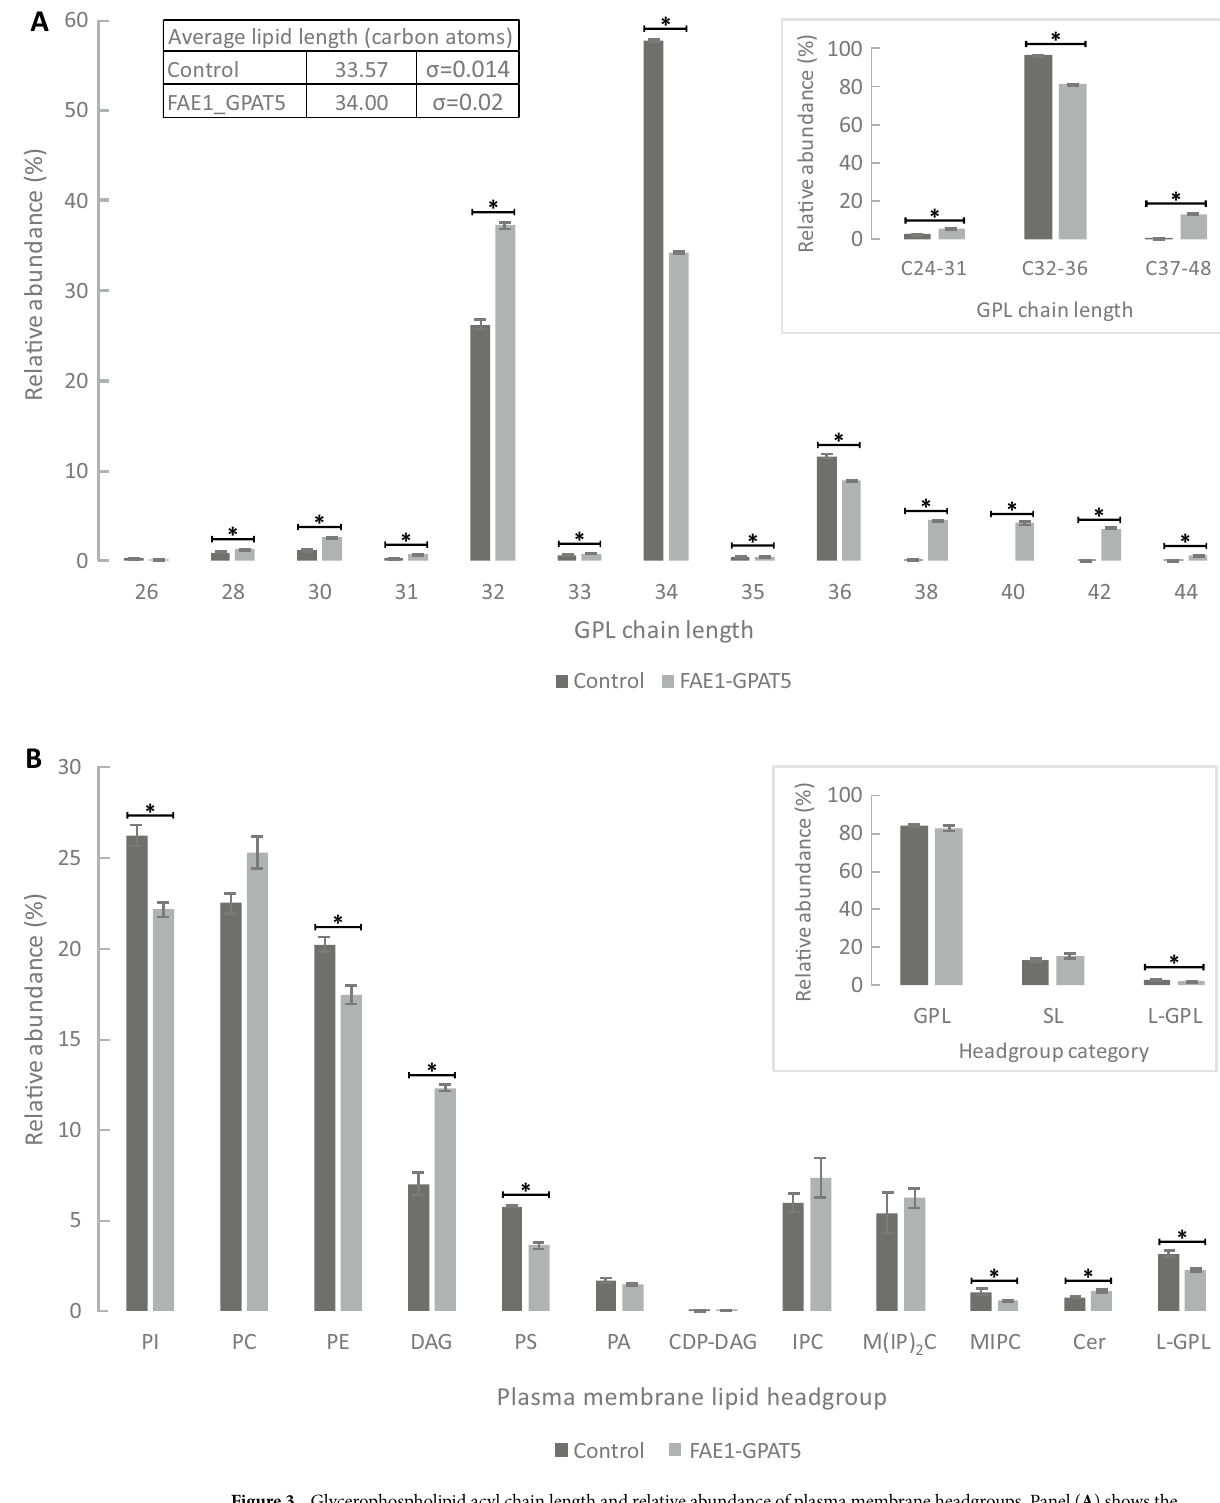
Figure 3. Glycerophospholipid acyl chain length and relative abundance of plasma membrane headgroups. Panel ( A ) shows the combined chain length of the two acyl chains of glycerophospholipids obtained from total lipid analysis for both the control strain (black) and the FAE1_GPAT5 double expression strain (grey). The average carbon length of the FA chains is shown in the table and the cumulative relative amounts of medium- (C24-31), long- (C32-36) and very-long- (C37-48) chain glycerophospholipids are shown in the insert. Panel ( B ) shows the relative abundances of membrane lipid headgroups, and the insert shows the cumulated amounts of different lipid classes. Asterisks indicate significant differences at the 95% confidence level. CDP-DAG cytidine diacylglycerol; Cer ceramides, DAG diacylglycerol, GPL glycerophospholipid; IPC inositol phosphorylceramide; L-GPL lyso-glycerophospholipid,